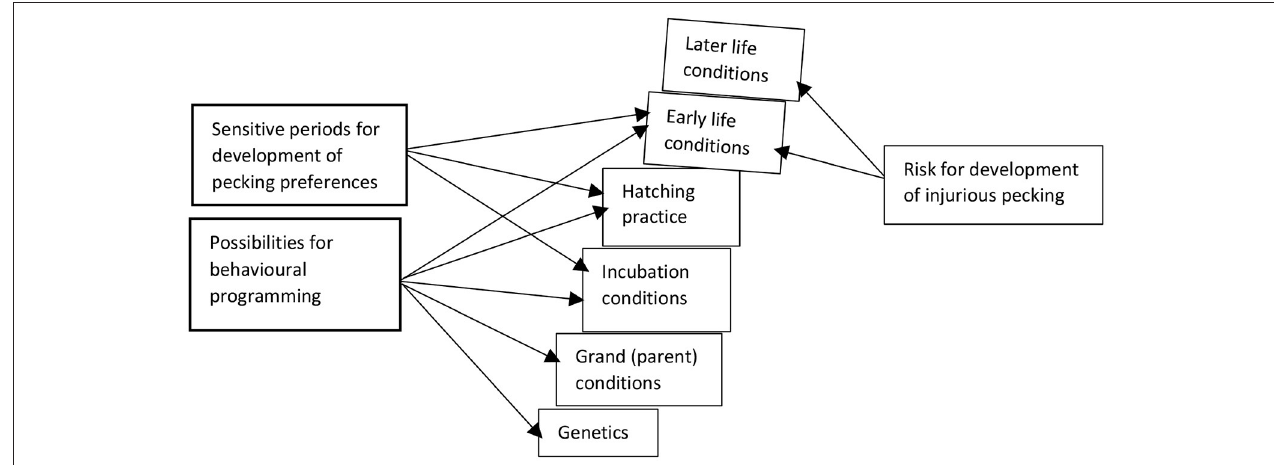
FIGURE 6 | Jenga tower of risks for development of injurious pecking in laying hens, based on aspects in the production chain where possibilities for behavioural programming could occur and sensitive periods in early life could prime pecking